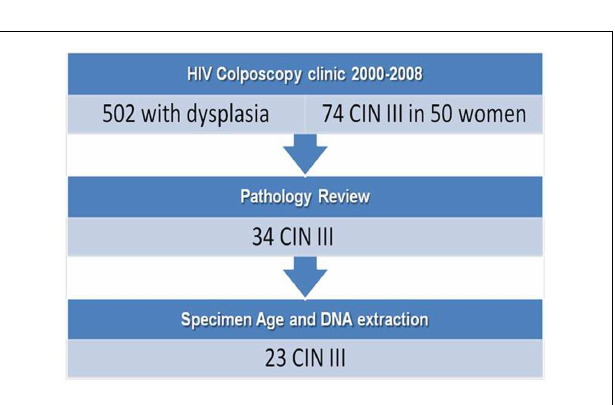
FIGURE 1 | Human papillomavirus type prevalence in different grades of dysplasia pooled estimates from all continents, general population (22, 23) .